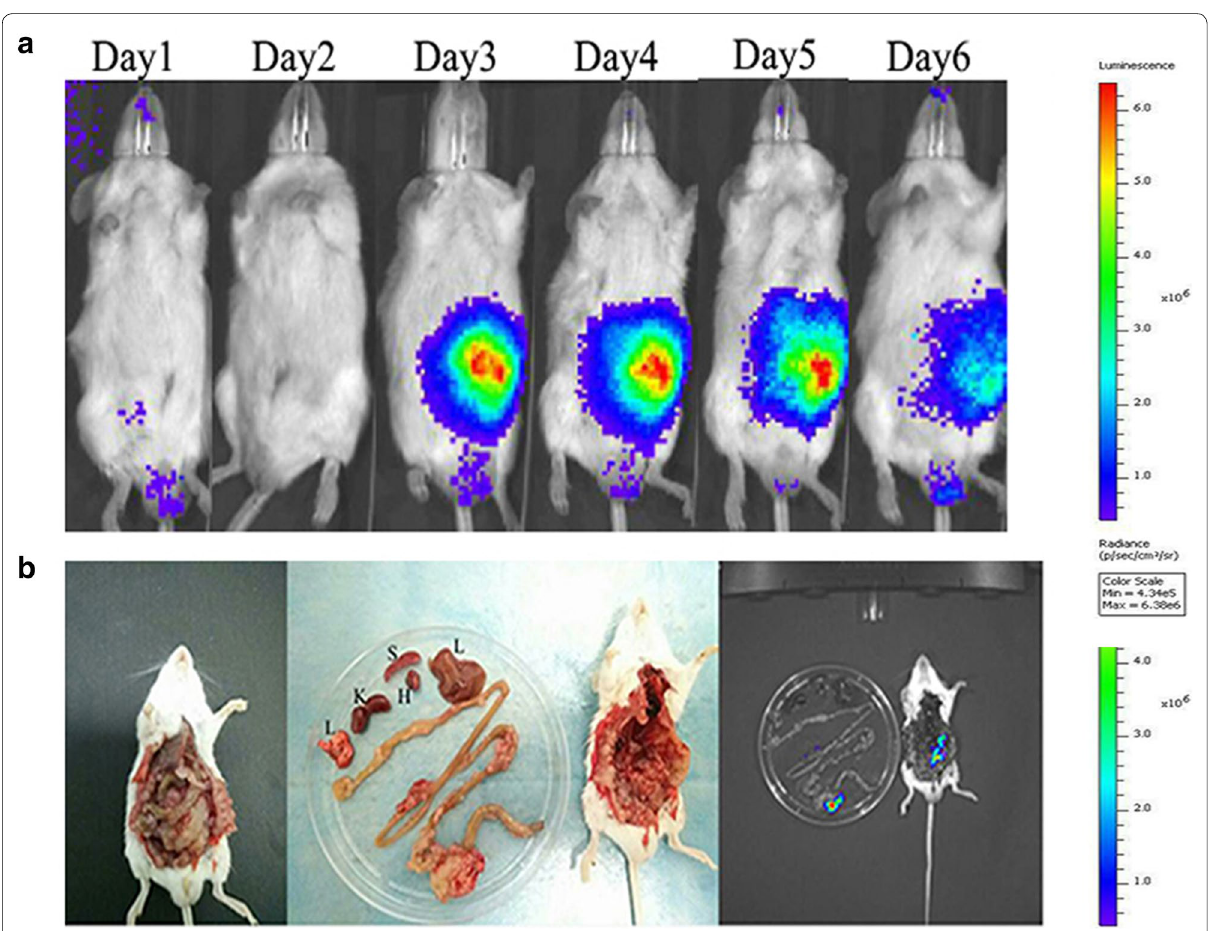
Fig. 2 Imaging of lux/pT-ClyA-expressing S. typhimurium in a mouse model of cecal colon cancer. BALB/c mice were surgically implanted with CT26 tumors, each measuring 1–2 mm 3 , with fragments being transplanted onto the ceca colon. Distribution of bacteria visualized by in vivo bioluminescence imaging after injection of engineered Salmonella typhimurium secreting lux/pT-ClyA. Images show representative mice before and after euthanasia. a Bioluminescence image shows that bacteria began to colonize the tumor the third day after the injection of the engineered bacteria into the tail vein. b On the sixth day, mice were dissected. L liver, S spleen, K kidney, H heart, L lung (the above images are from the same